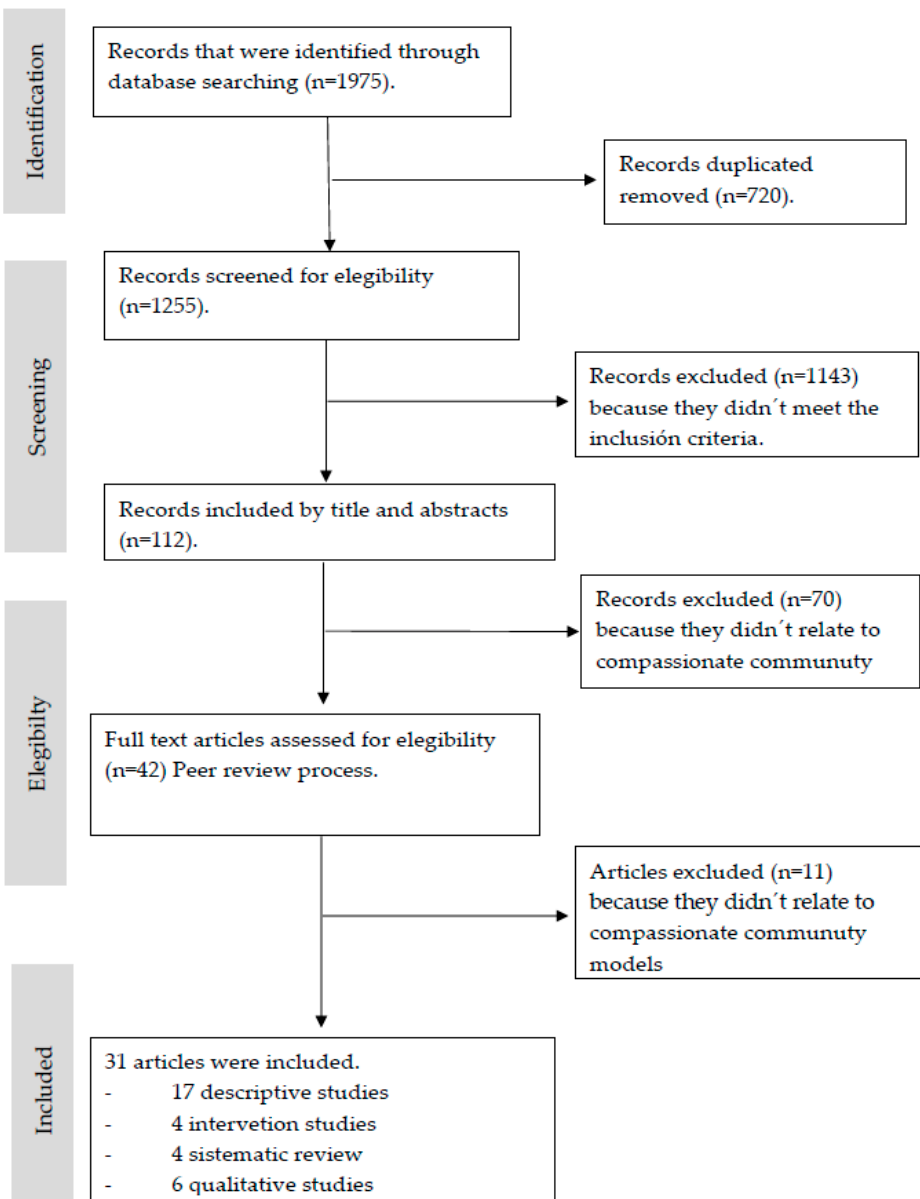
Figure 1. The flow diagram of literature search and selection of articles.